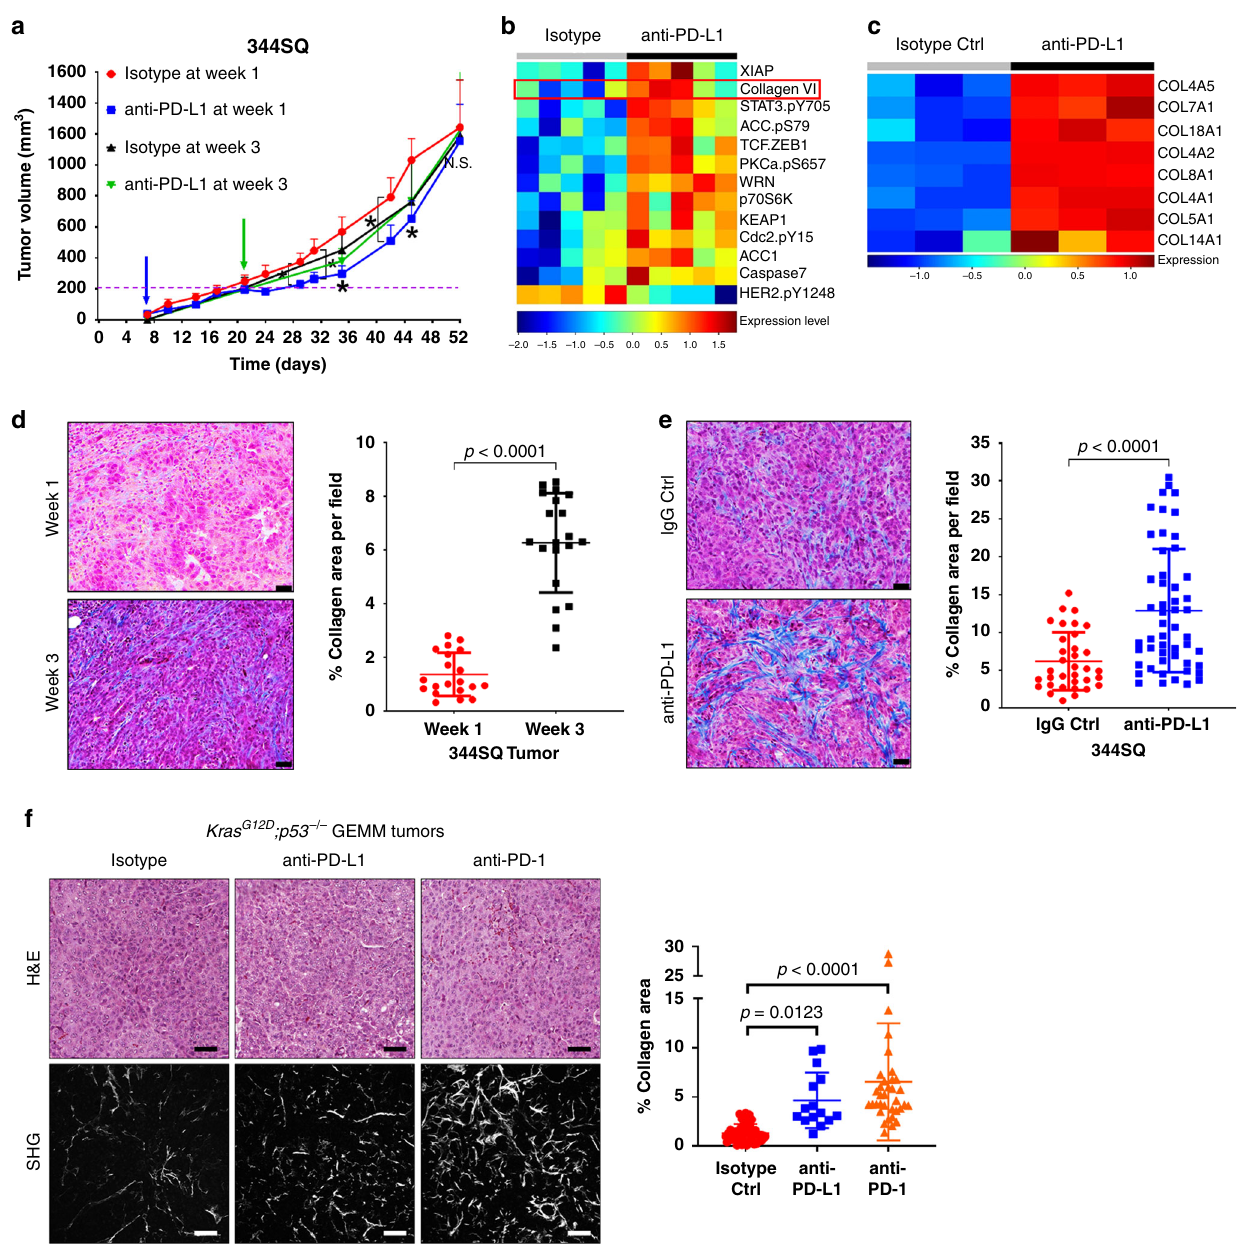
Fig. 1 PD-(L)1 blockade is associated with increased intratumoral collagen deposition. a In vivo volume measurements at indicated time points for 344SQ subcutaneous tumors implanted in syngeneic WT mice treated weekly with anti-PD-L1 (200 µ g/mouse) or isotype control (200 µ g/mouse). Treatment start time denoted by blue (1-week post-implantation) or green (3-week post-implantation) arrow; n = 5 mice per treatment group. Statistics calculated using a one-way repeated mixed-effects model (REML) with * p = 0.0371. b Heatmap of RPPA pro fi le showing statistically signi fi cant (FDR < 0.05) differentially expressed proteins in 344SQ subcutaneous tumors treated weekly with anti-PD-L1 or isotype control, starting 1-week post-implantation in mice. Tumor samples were collected for RPPA at the endpoint of experiment in ( a ), ~7 weeks, when tumors developed resistance. c Heatmap of statistically signi fi cant (FDR < 0.05) differentially expressed mRNAs related to collagen genes in 344SQ tumors treated weekly with anti-PD-L1 or isotype control, starting after one week of implantation. Tumors samples and RNA pro fi ling data were obtained from a prior study 8 at treatment endpoint, ~8 weeks, when tumors developed resistance. d Representative Masson ’ s trichrome stains and quanti fi cation of percent collagen area per fi eld of untreated 344SQ tumors collected at 1 or 3 weeks post-implantation in mice; n = 5 tumors per time point and four microscopy fi elds per tumor sample were analyzed. Scale bars, 50 µ m. Statistics calculated using two-sided student ’ s t -test. e Representative trichrome stains and quanti fi cation of percent collagen area per fi eld of 344SQ tumors treated weekly with IgG isotype control or anti-PD-L1, starting after 1 week of implantation. Tumors were analyzed at endpoint of the experiment in ( a ); n = 5 tumors per treatment group with 34 total microscopy fi elds analyzed for IgG Ctrl and 52-total fi elds analyzed for anti-PD-L1 groups. Scale bars, 50 µ m. Statistics calculated using a two-sided student ’ s t -test. f Left: Representative H&E stains and SHG microscopy, including SHG quanti fi cation of percent collagen area per fi eld of lung tumor tissues from Kras G12D ;p53 -/- (KP) mice treated weekly with anti-PD-1, -PD-L1 or isotype control for 12 – 14 weeks; n = 5 lung tissues per treatment group with 45 (isotype Ctrl), 15 (anti-PD-L1), and 35 (anti-PD-1) total microscopy fi elds analyzed across all tissues in respective groups. Scale bars, 100 µ m. Data presented as mean + / − SD. Statistics calculated using one-way ANOVA post hoc Tukey for multiple comparisons. * P <